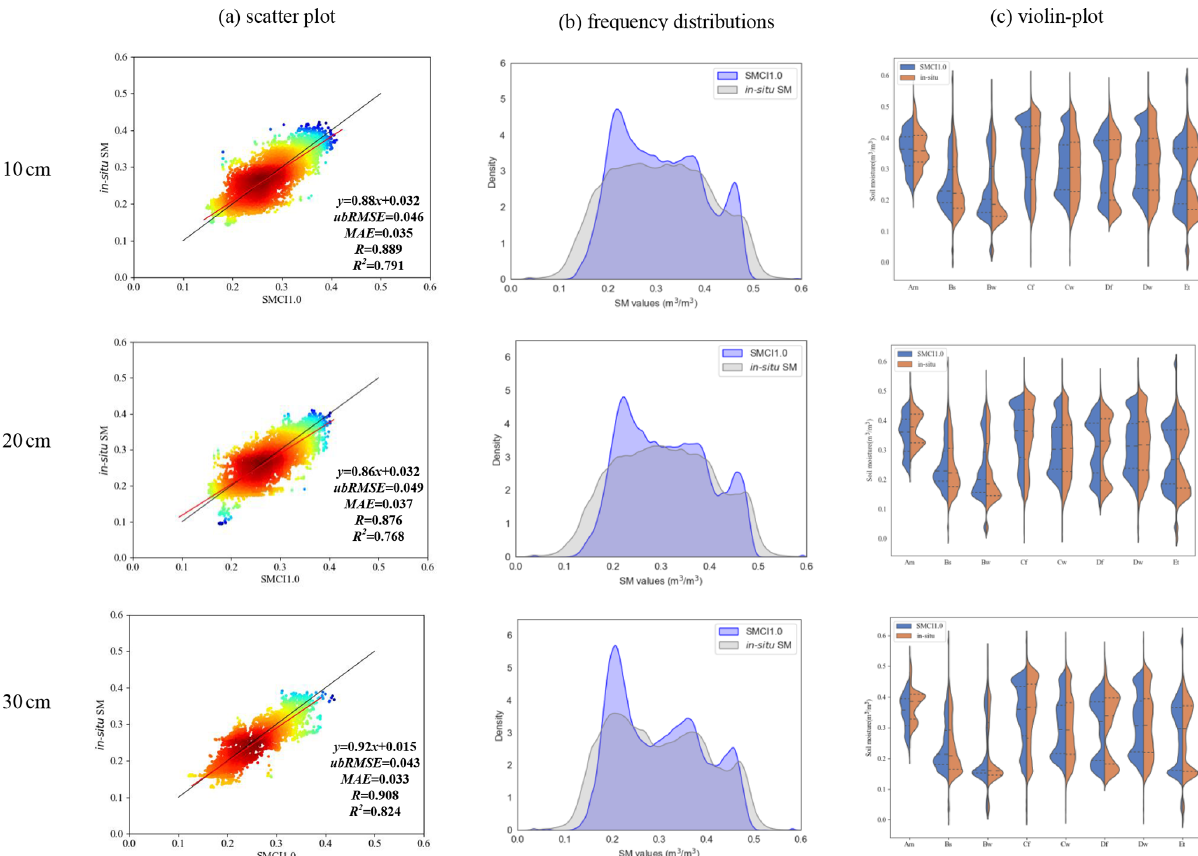
Figure 2. Comparisons between SMCI1.0 and in situ SM from 10 to 30cm soil depth in the year-to-year experiment: comparison of (a) the scatter plot between the mean of SMCI1.0 and that of in situ SM at each station, (b) the frequency distributions of all SM values in SMCI1.0 and that in in situ measurements, and (c) the violin plot for the distribution of daily SM from stations for each climate